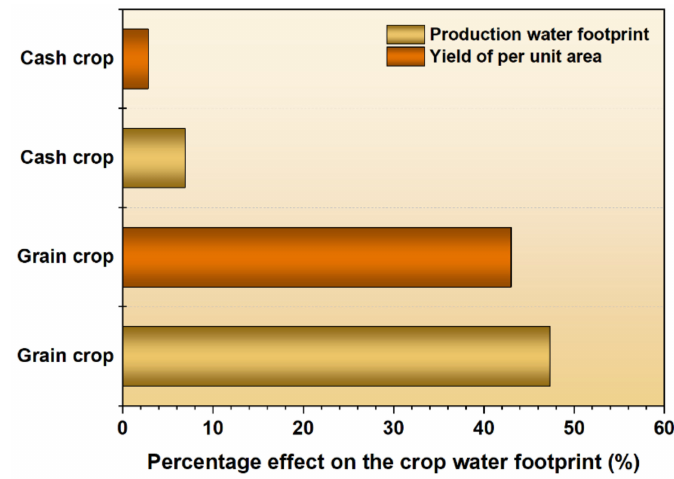
Figure 8. Sensitivity analysis of regional crop water